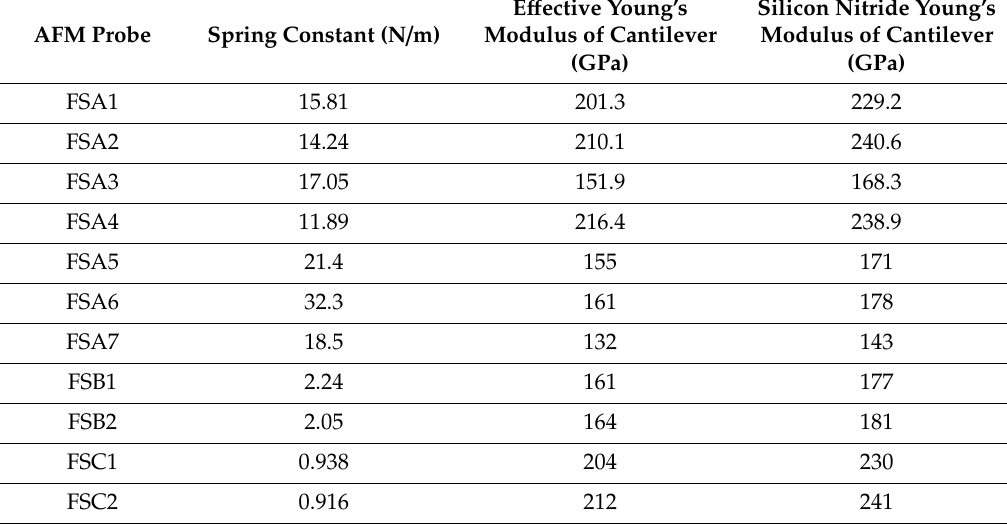
of the silicon nitride the cantilevers are composed of which has been corrected for the thin metal coatings on the back of the cantilevers using equations derived by Sader et al. [53].